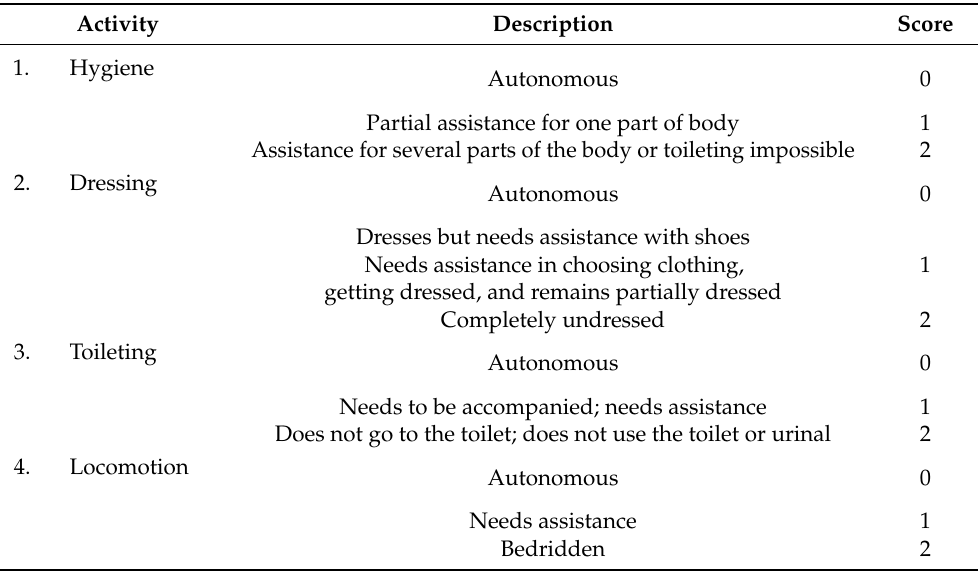
Table 3. Scale of basic activities of daily living